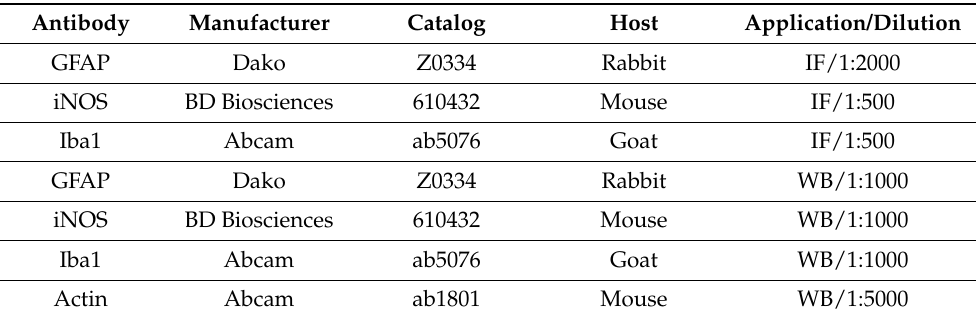
Table 1. Antibodies, sources and dilutions used in this